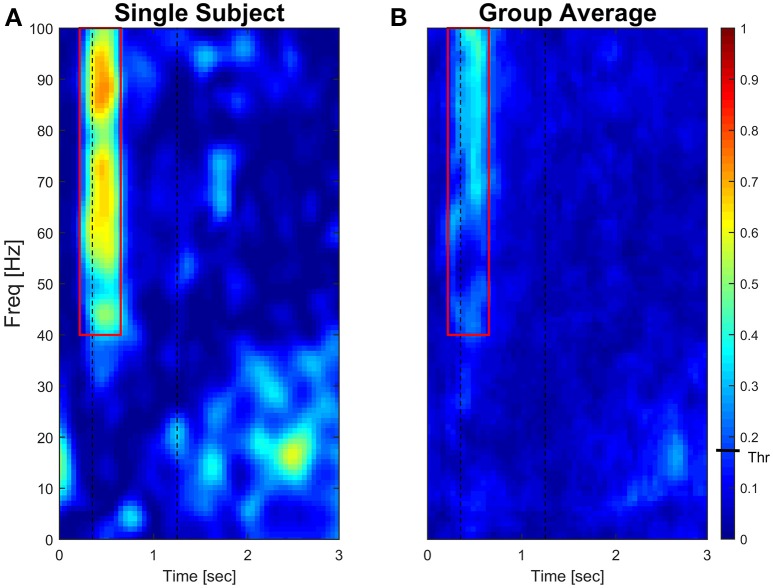
Subject-specific and group-averaged time-frequency IMC during late adaptation (Block12) for PD-FCR. Color-coded absolute IMC data from a typical subject (A) and averaged for the group (B; N = 16) during late adaptation (Block 12) for the PD-FCR muscle pair. A significant increase of coherence is shown in high-frequencies straddling the beginning of the movement both at subject and group level. Dashed black vertical lines represent averaged movement onset and offset for Block12. Continuous red lines represent window of interest straddling movement onset in the high-frequency range in which IMC absolute values are significantly different from zero. The confidence interval is represented by a black bar on color scale (Thr)–all colors above bar are significantly different from zero.